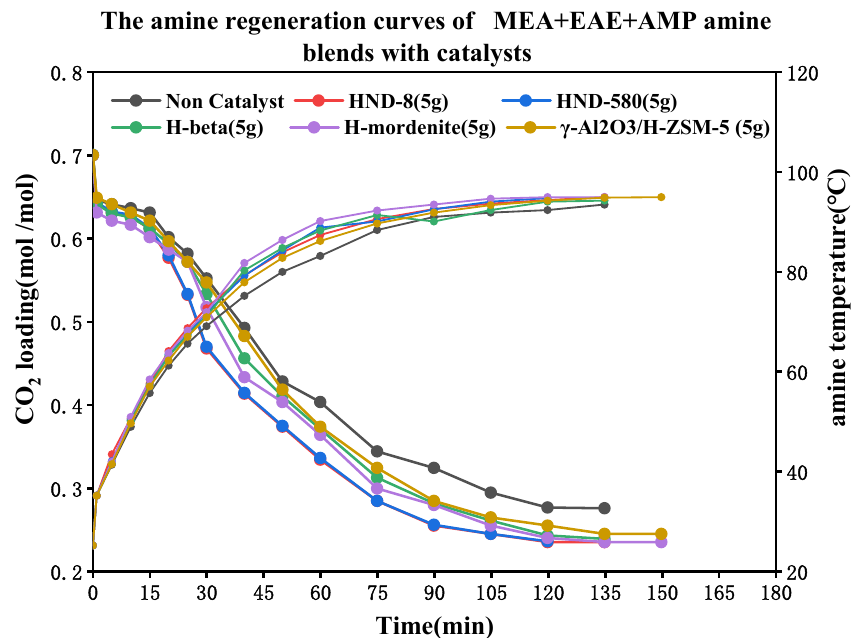
Figure 10. The CO 2 desorption profiles of MEA + EAE + AMP at 0.2 + 1 + 3 mol/L with catalysts.